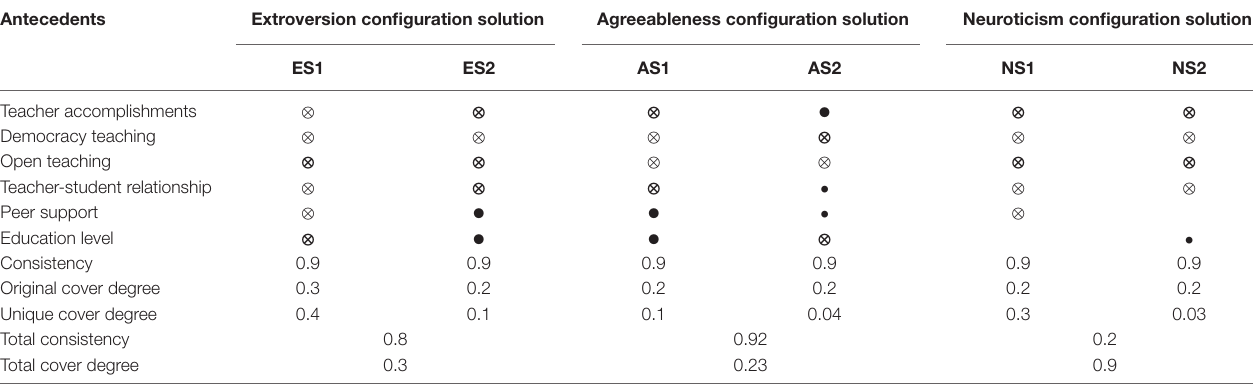
TABLE 9 | Matching analysis of school experience and non-high original innovation personality.